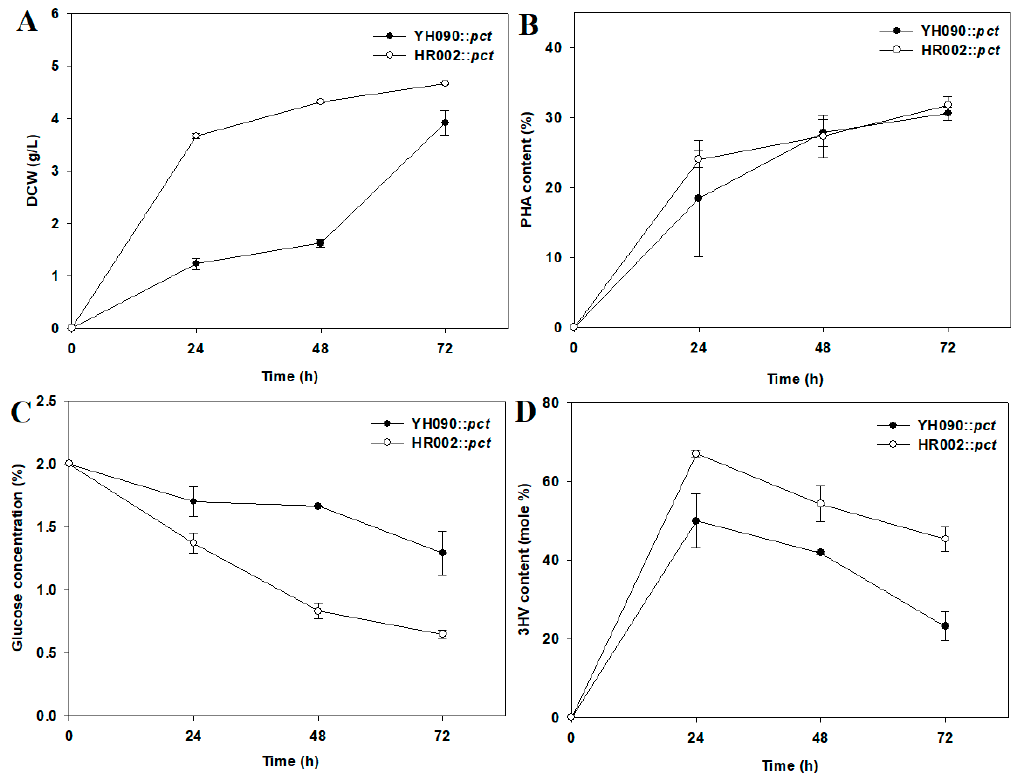
Figure 5. Monitoring of PHBV production in YH090:: pct and HR002:: pct : ( A ) DCW (dry cell weight, g/L); ( B ) PHA content (wt/wt %); ( C ) Glucose concentration (g/L); and ( D ) 3-hydroxyvalerate monomer content (mol %). Cell cultivation was conducted for 72 h in M9 minimal medium containing 2% glucose and 0.15% sodium propionate. Error bars represent the standard deviations of two replicates.